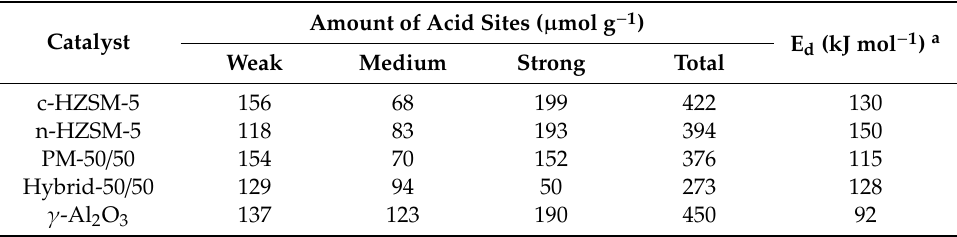
Table 3. NH 3 -TPD results for the catalysts used in this